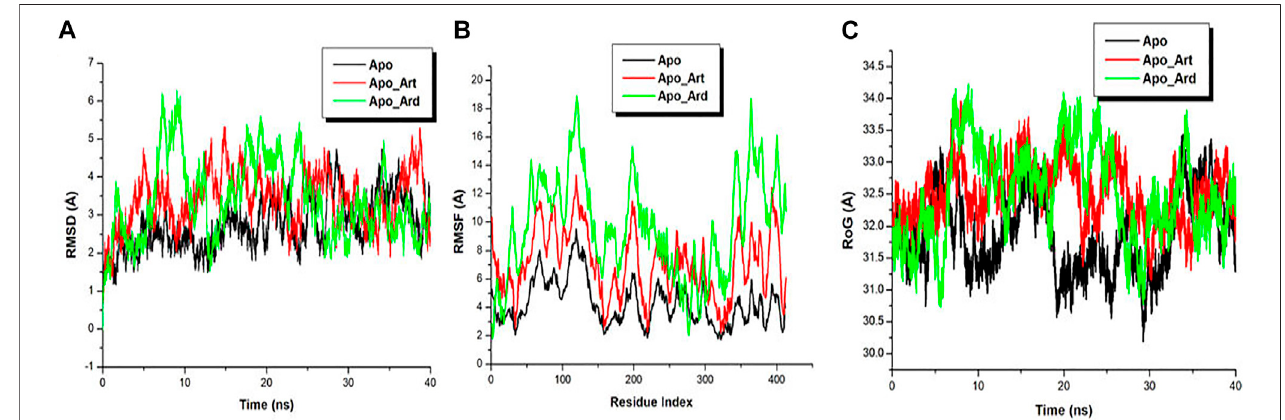
FIGURE1| ConformationalanalysisplotshowingstabilityandatomisticmotionsamongApo( black ),Apo_Art( red ),andApo_Ard( green )systems (A) .C- α RMSF plot showing the residual fl uctuation of Apo ( black ), Apo_Art ( red ), and Apo_Ard ( green ) systems (B) . RoG plot showing the residual compactness of Apo ( black ), Apo_Art ( red ), and Apo_Ard ( green ) systems (C) .